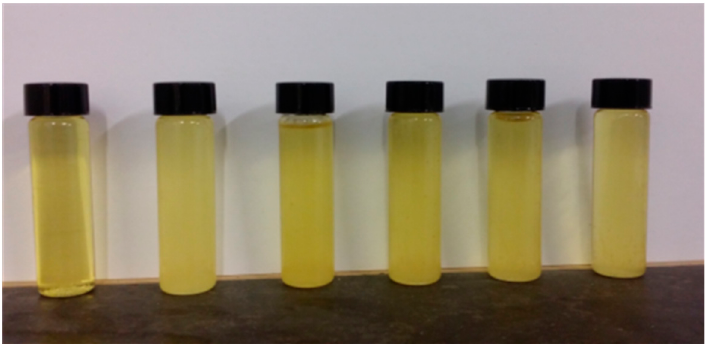
Figure 1. Fuel samples (from left to right): Diesel, J100, J100A100, J100A50, J10°C100 and J10°C50.